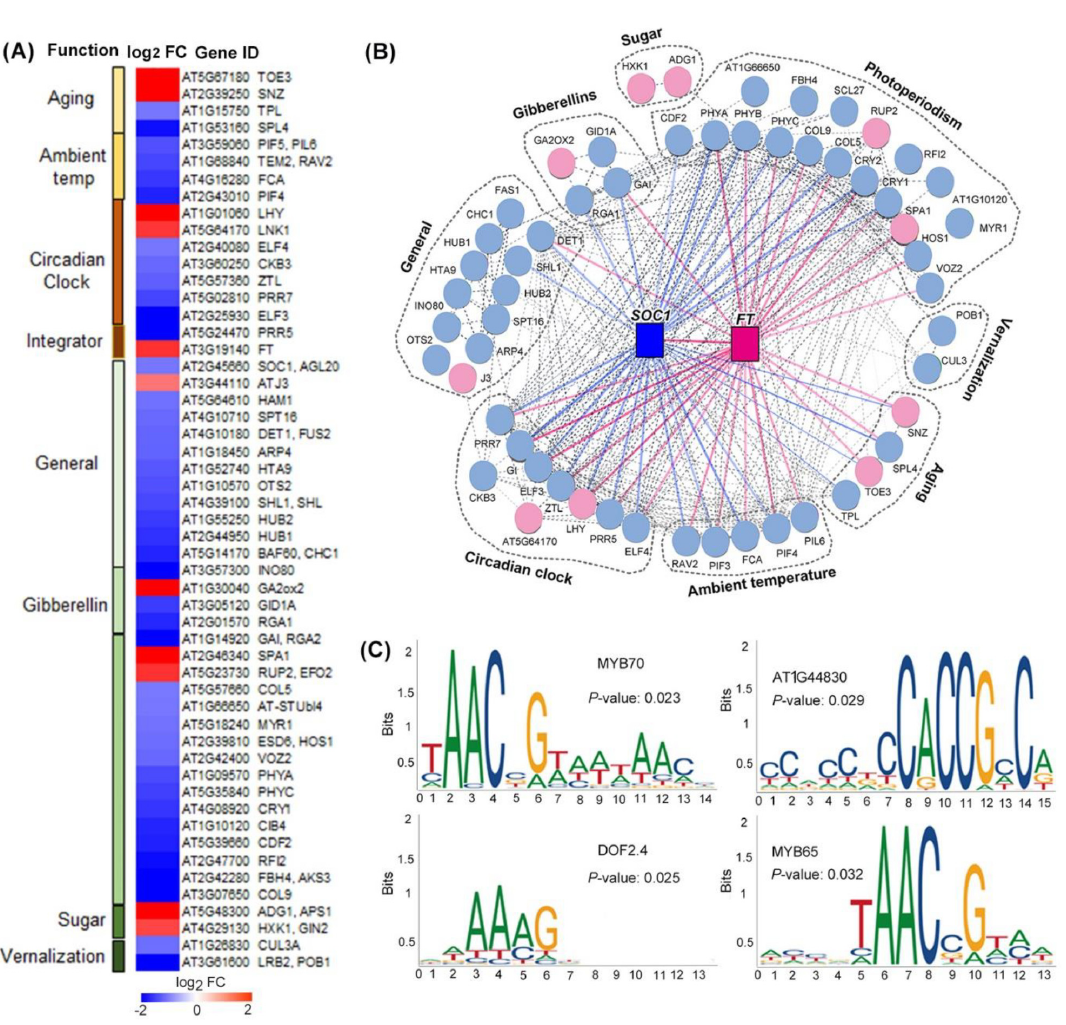
Figure 10. Interaction networks of flowering genes in response to spaceflight conditions. ( A ) Heatmap showing fold changes (FC) in transcript abundance of spaceflight samples in comparison with the ground control (log 2 FC). ( B ) Diagram of the protein interaction networks of flowering genes, which up-regulated and down-regulated expression levels under spaceflight conditions in comparison with their controls on ground. The up-regulated genes are shown in pink and down- regulated genes are shown in blue. ( C ) Four overrepresented motifs enriched in upstream promoter sequences of genes in flowering function classification in Figure 9, as detected by the plant regulomics (bioinfo.sibs.ac.cn/plant-regulomics, update 9 July 2021). Indicated are the p -values representing the statistical significance of the motif. To test whether there are potential common cis-acting elements among these spaceflight responsive flowering genes, we performed analyses using Plant Regulomics (bioinfo.sibs.ac.cn/plant-regulomics) to find overrepresented motifs in the 1-kb upstream sequence of the overrepresented genes in these 53 flowering genes. Thirty coregulated genes were identified to share four common motifs, of which the occurrence was significantly high as compared to that in random genomic regions (Figure 10C). These include (T/C)AAC (C/G)G, which is identical to MYB70 (AT2G23290) and MYB 65 (AT3G11440). The expression of genes regulated by MYB65 was consistent with roles in GA-mediated processes, with the expression of MYB 33 at the shoot apex coinciding with